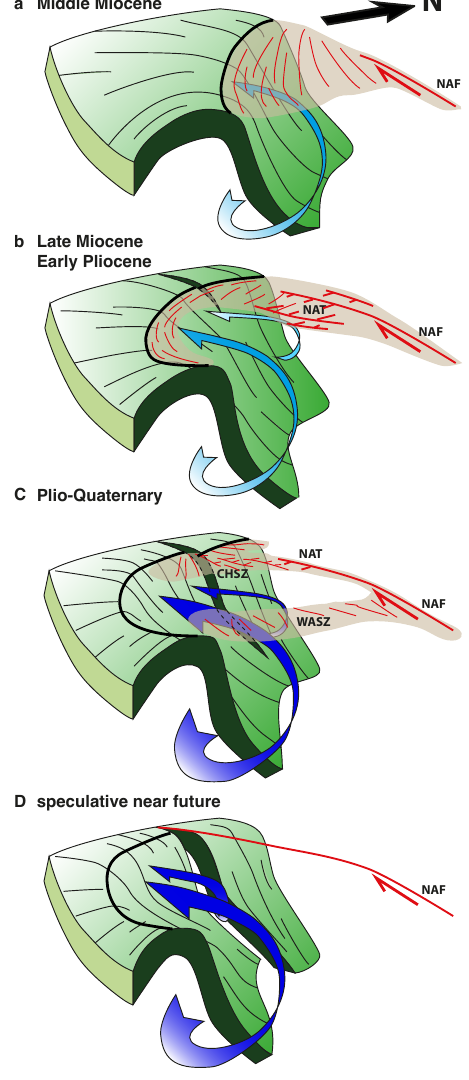
Fig. 12. 3-D sketches (redrawn after Jolivet et al., 2013) showing middle Miocene to present-day evolution of slab geometry, mantle flow and overriding plate deformation in the Aegean–Anatolian re- gions and speculative interpretation of their evolution in the near future on the basis of outputs from the three-dimensional dynamic